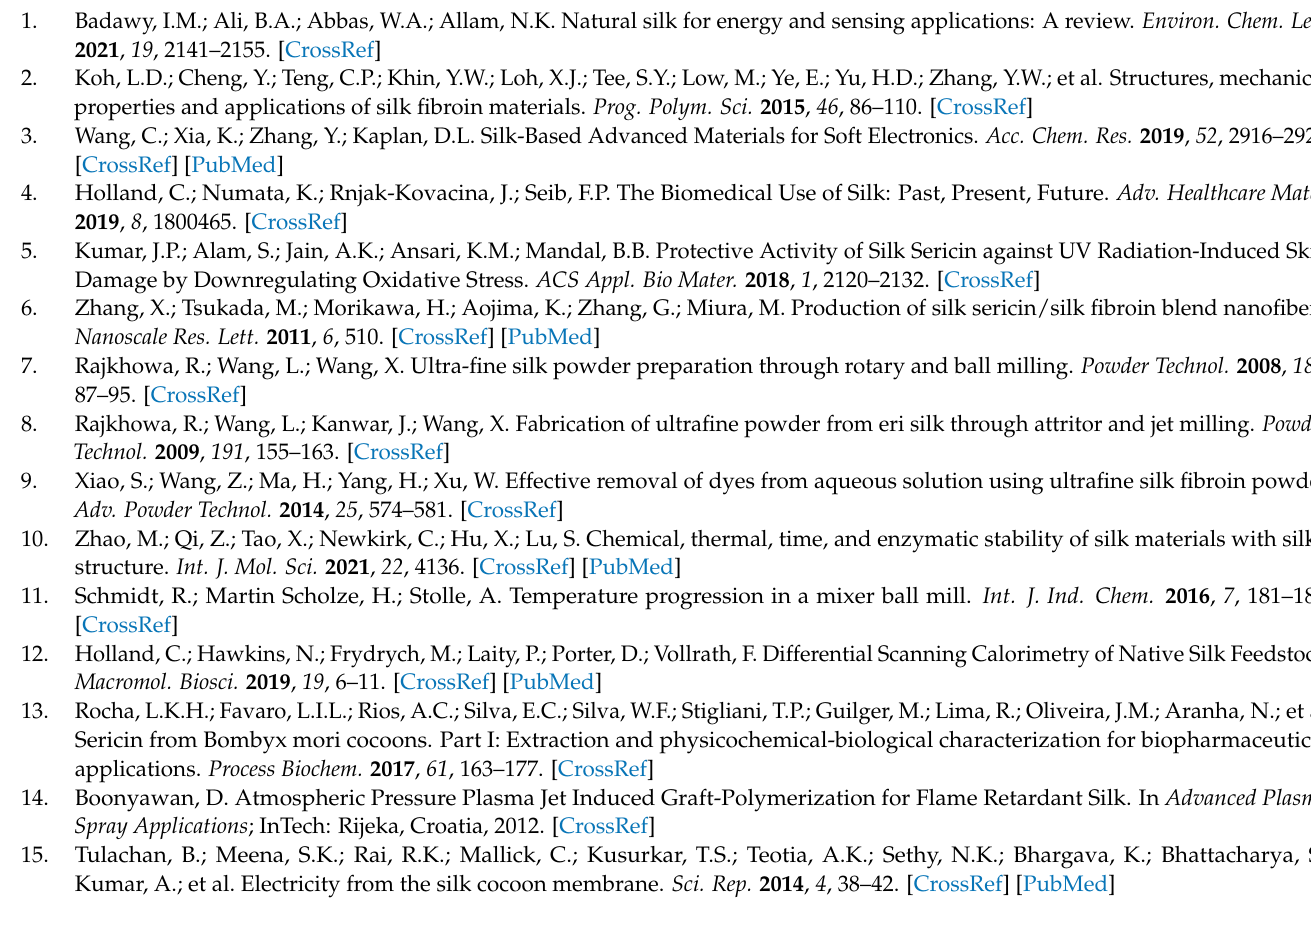
Figure S4: Infrared absorption spectra of (a) raw, and (b) degummed silk cocoons, (c) silk fabric, and silk powders from (a) raw cocoons, (b) degummed cocoons, and (c) silk fabric; Table S1: The onset, and end temperatures, peak (T d ) of degradation process, and degradation enthalpy value ( ∆ H deg ) obtained from DSC analysis for raw, degummed silk cocoons and silk woven textile before and after cryogenic milling; Table S2: The onset, and end temperatures, and peak of degradation process, obtained from TG/DTG analysis for raw, degummed silk cocoons and silk woven textile before and after cryogenic